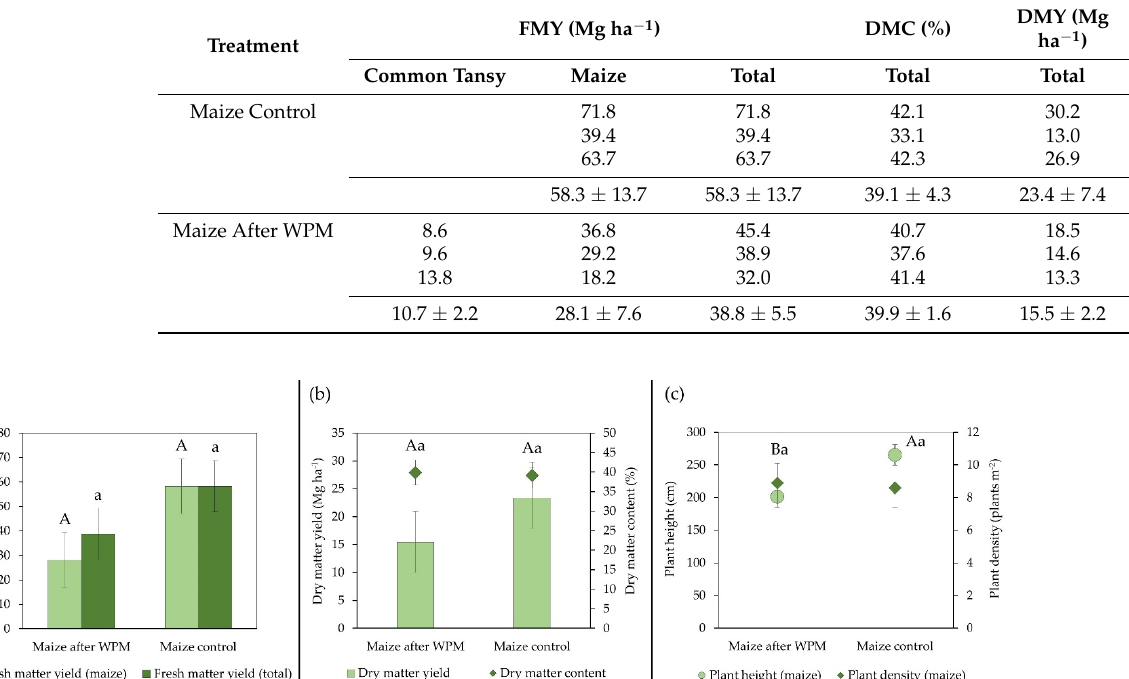
8.9 ± 0.7 Table 2. The raw data, average values and standard deviations of the fresh matter yields (FMYs) of common tansy and maize and the total biomass (maize + the common tansy) per treatment. For the total biomass, the dry matter content (DMC) and dry matter yield (DMY) are also shown. Treatment